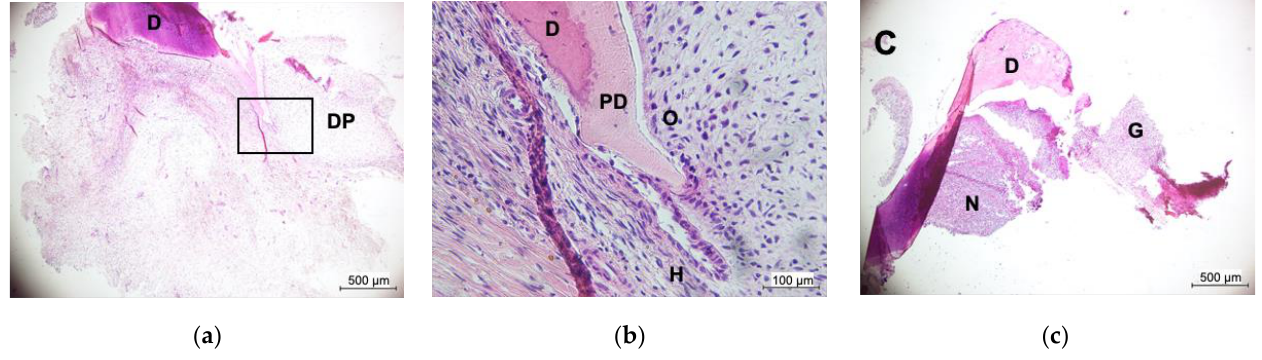
Figure 5. Histopathological examination of the mandibular right primary lateral incisor (hematoxylin-eosin staining). ( a ) Lower magnification of the root apex region. ( b ) A magnified view of the area in ( a ) enclosed by a square. ( c ) Lower magnification of pulp in the crown area. DP: dental papilla, D: dentin, PD: pre-dentin, O: odontoblast, H: Hertwig’s root sheath, N: neutrophil, and G: granulation tissue.